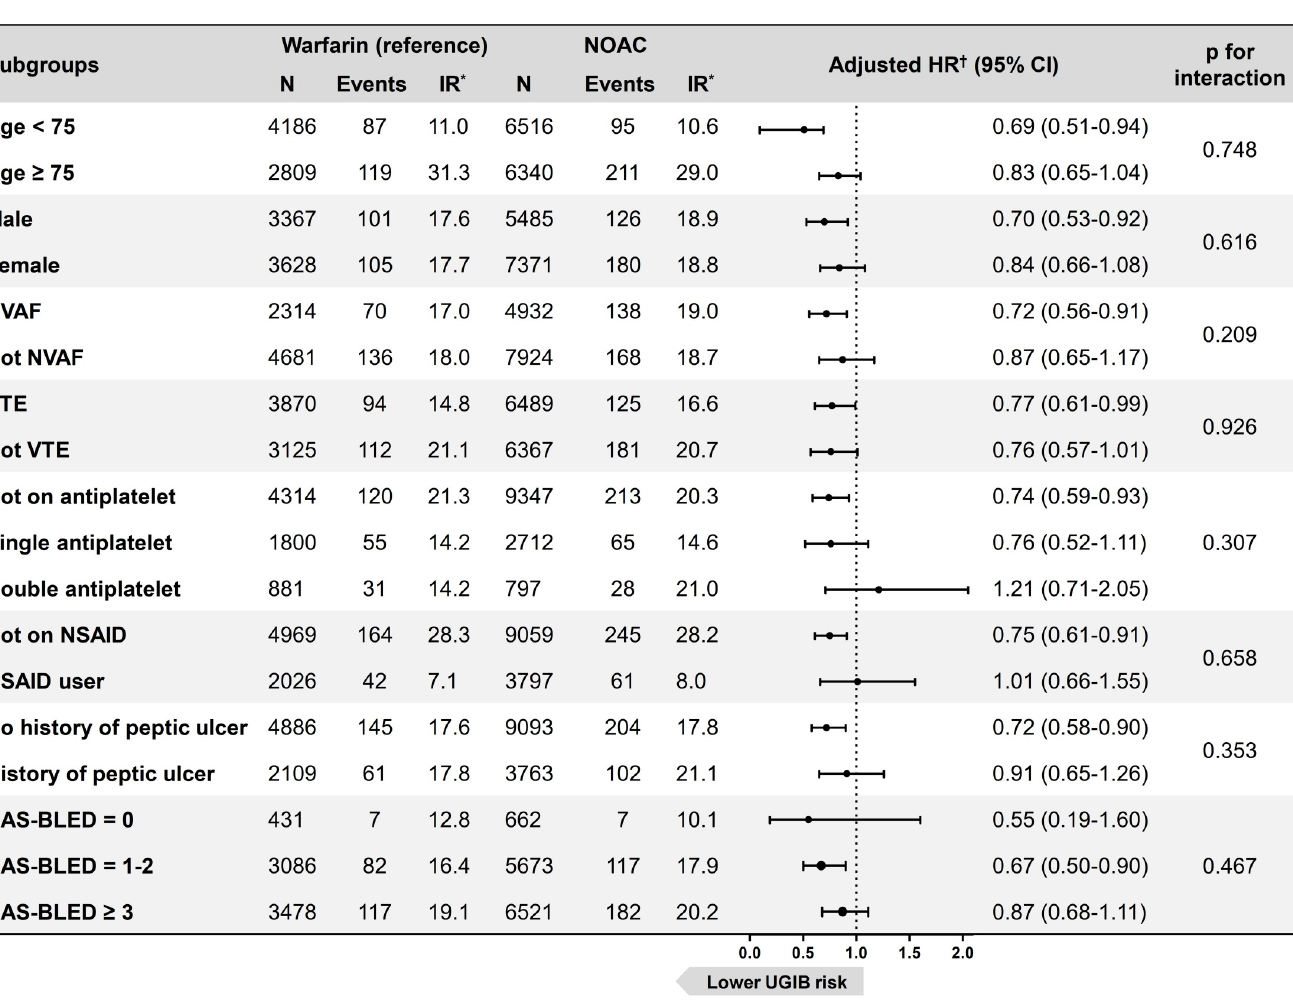
Fig 5. Upper gastrointestinal bleeding risk of NOACs with reference to warfarin in various subgroups. � IR: incidence rate per 1000 person-years. † Adjusted for age, sex, atrial fibrillation, venous thromboembolism, comorbidities (hypertension, diabetes mellitus, chronic kidney disease, ischemic heart disease, heart failure, peptic ulcer disease), and concomitant use of aspirin, P2Y 12 inhibitor, and nonsteroidal anti-inflammatory drug. NOAC, non-vitamin K antagonist oral anticoagulant; NSAID, nonsteroidal anti-inflammatory drug; NVAF, non-valvular atrial fibrillation; UGIB, upper gastrointestinal bleeding; VTE, venous